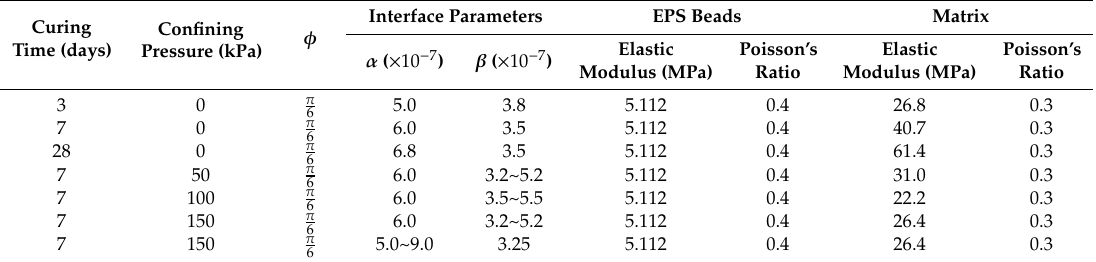
Table 2. Mechanical properties of components and parameters of imperfect interface